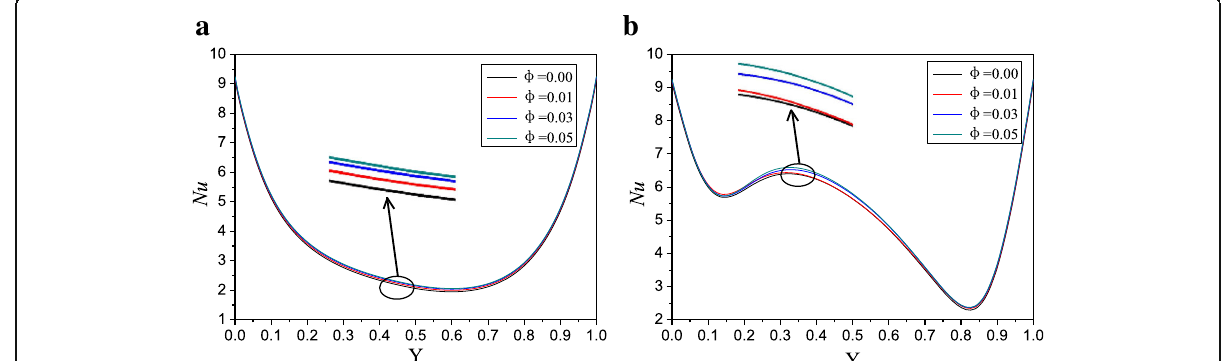
Fig. 5 Nusselt number distributions with different volume fractions, A = 2:1. Nusselt number distributions of Ag-Ga nanofluid with different volume fractions along with the left hot wall, A = 2:1, r = 20 nm. a Ra = 1 × 10 3 . b Ra = 1 × 10 5